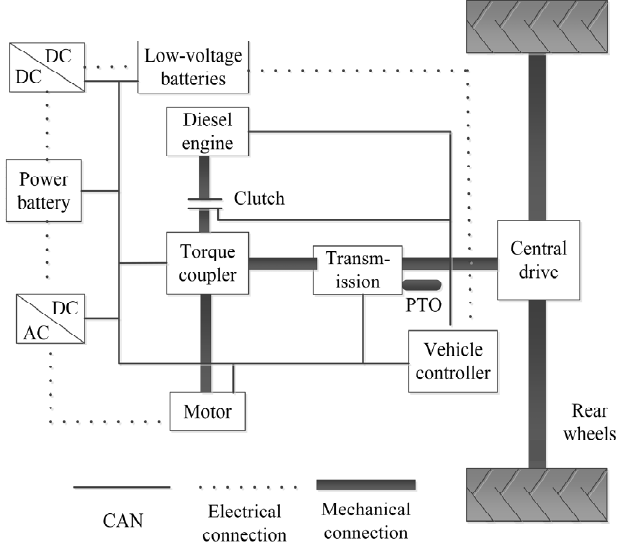
Figure 1. Topology of a diesel–electric parallel hybrid tractor.